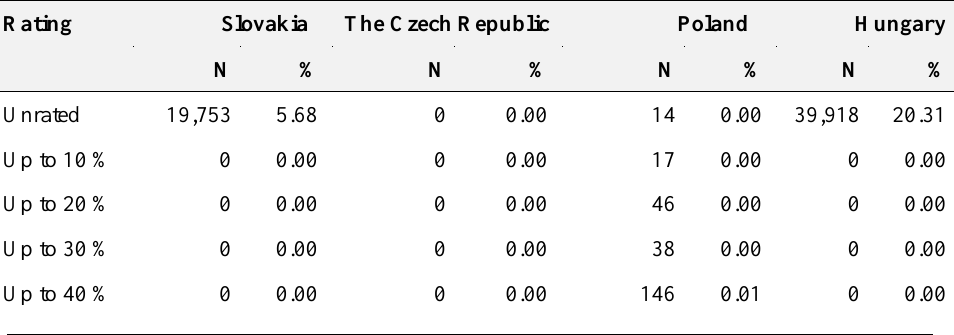
Table 4 – Number of reviews according to quality of communication